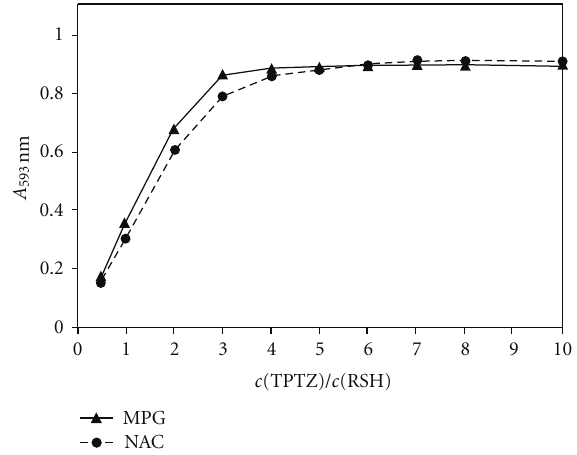
Figure 3: E ff ect of the TPTZ concentration on the absorbance at 593 nm for the fixed concentration of 40 μ M of the thiol (RSH) compound, that is, NAC or MPG, at pH 3.6 and 25 ◦ C. The concentration of Fe(III) was 0.2